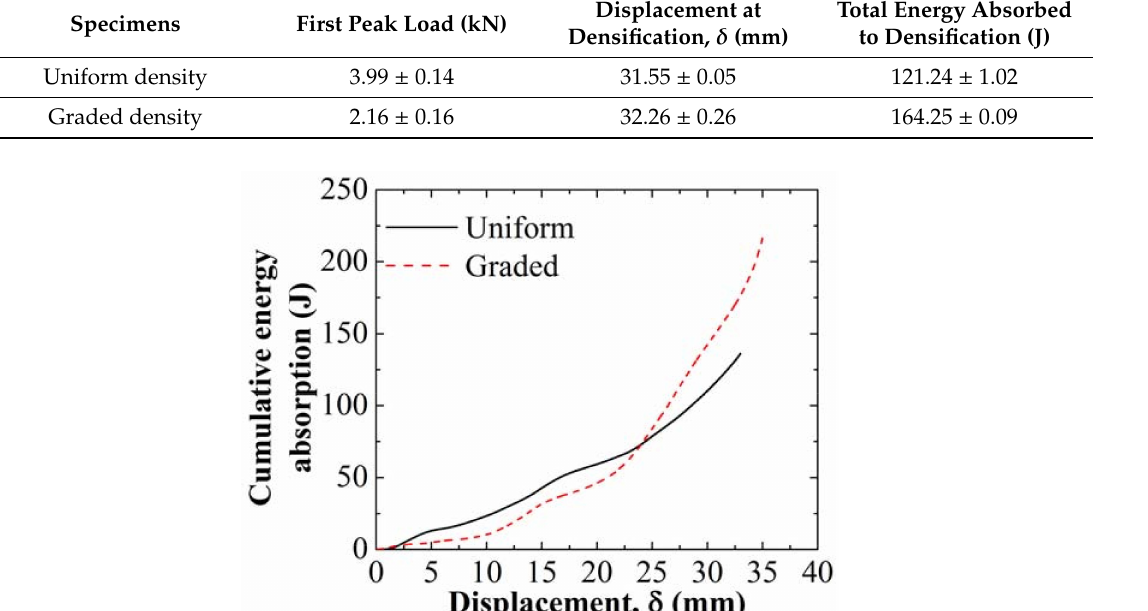
Figure 10. Cumulative energy absorption versus displacement curves for uniform density and graded density Kagome lattice